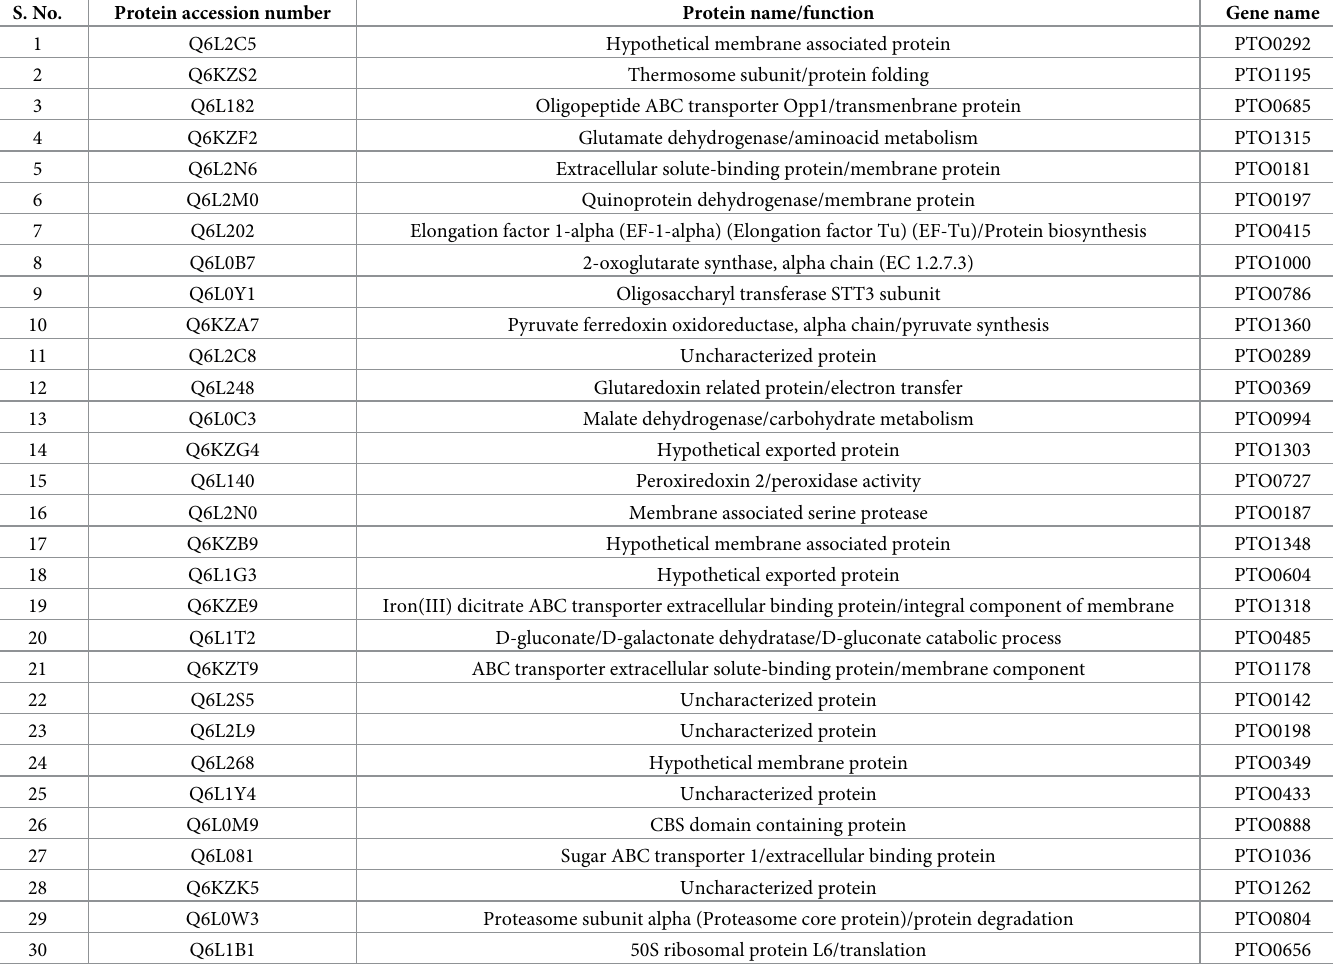
Table 1. Details of the 30 secretory proteins identified in the secretome of P . torridus by LC MS and the signal peptides predicted by various signal peptide predictors. S.